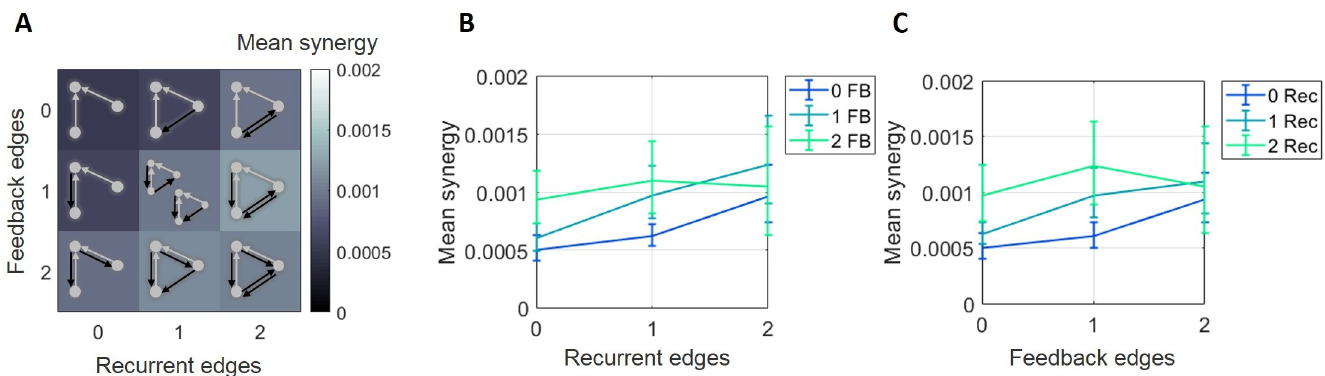
Fig 5. Raw synergy increased with greater recurrence and greater feedback. (A) Mean synergy increased with the number of recurrent and feedback edges in motifs. (B) Curves representing rows shown in A, plotted with errorbars computed across networks, show that synergy increased as the number of recurrent edges increased, although the difference in means across levels was not significant. (C) Curves representing columns shown in A, plotted with errorbars computed across networks, show that synergy increased as the number of feedback edges increased. Errorbars are 95% bootstrap confidence intervals around the mean.